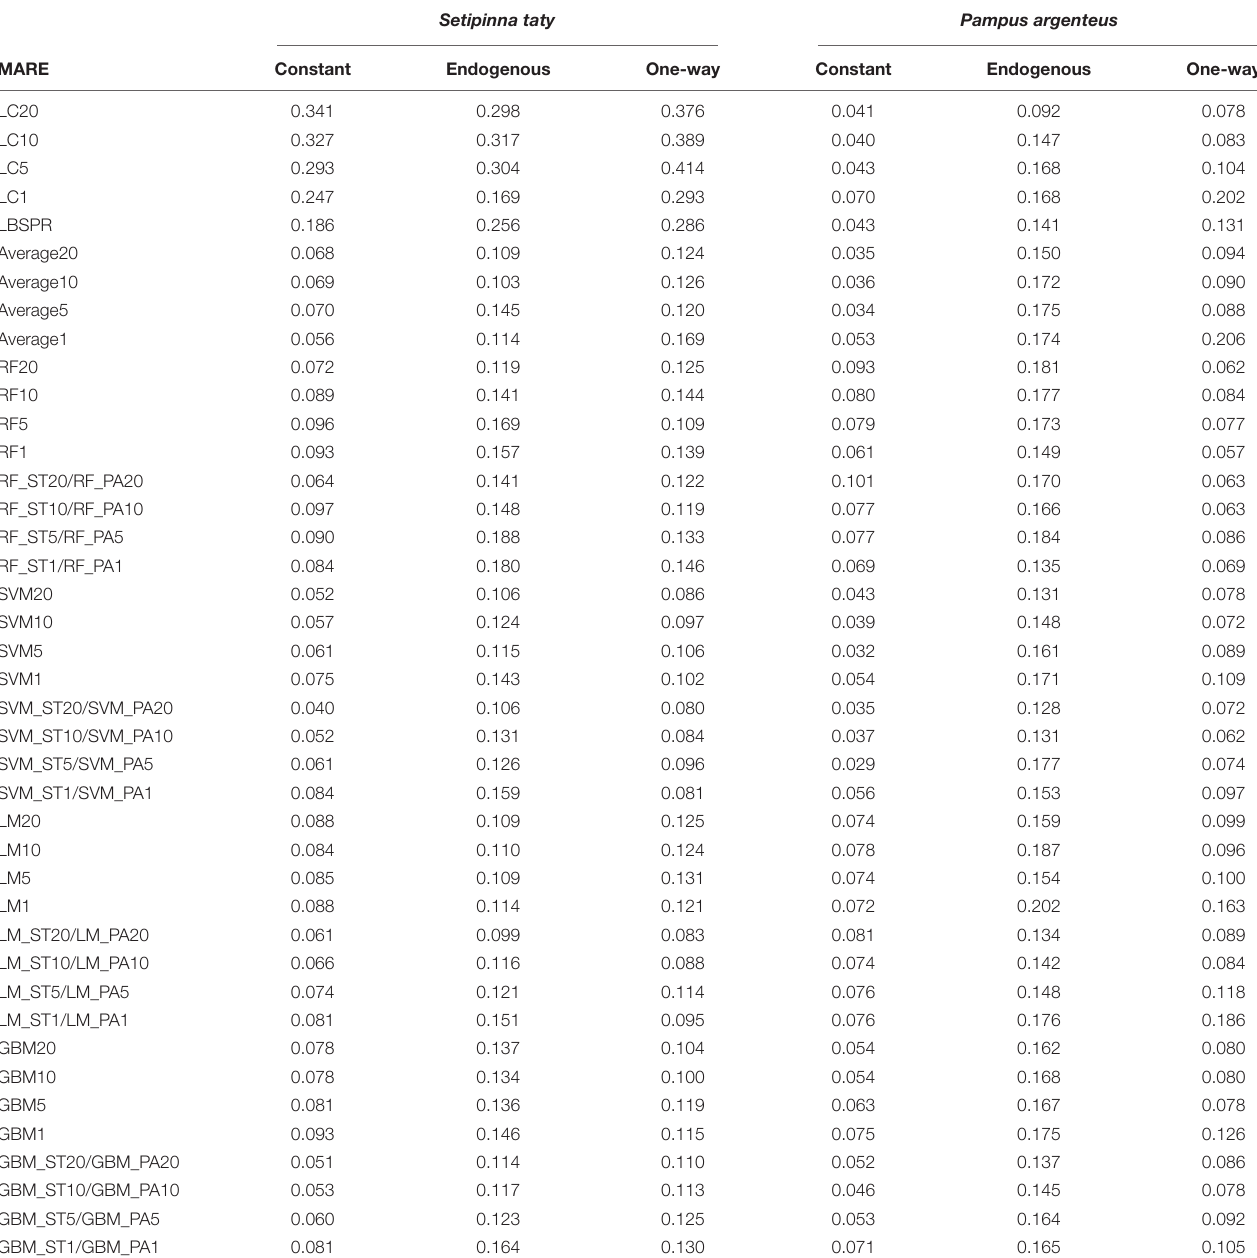
TABLE 2 | Ensemble models performance in estimates of status (SPR in the last year) compared with LB-SPR and LIME. Setipinna taty Pampus